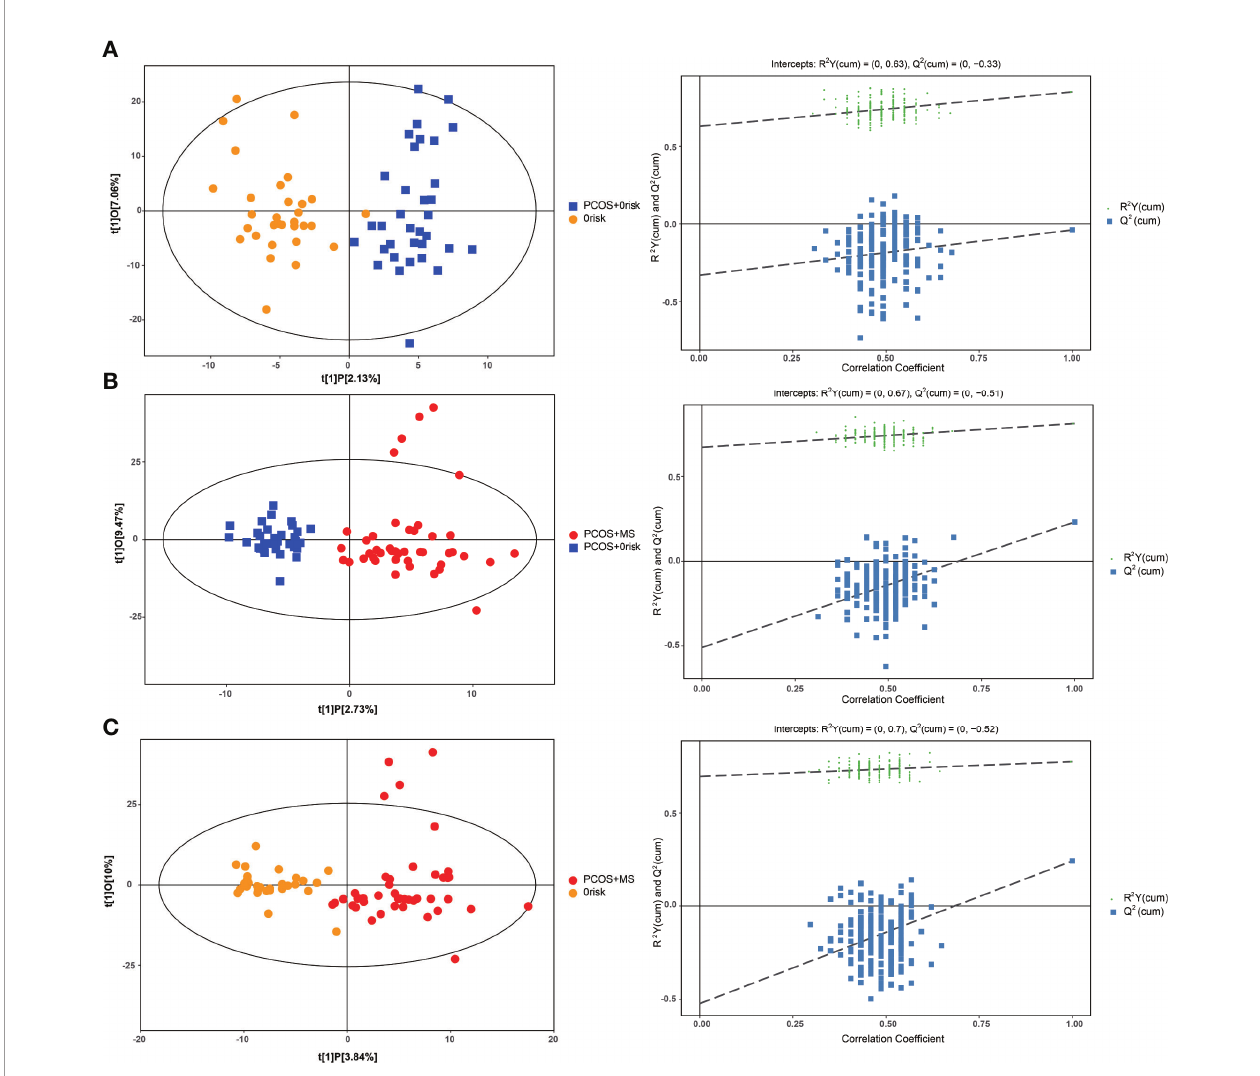
FIGURE 2 | OPLS-DA cross-validated scores (left column) and the permutation test (right column) of UPLC combined with LTQ-orbi-trap mass spectrometry of plasma samples from HC, PCOS, PCOS-MS. (A) PCOS vs . HC; (B) PCOS-MS vs . PCOS; (C) PCOS-MS vs .